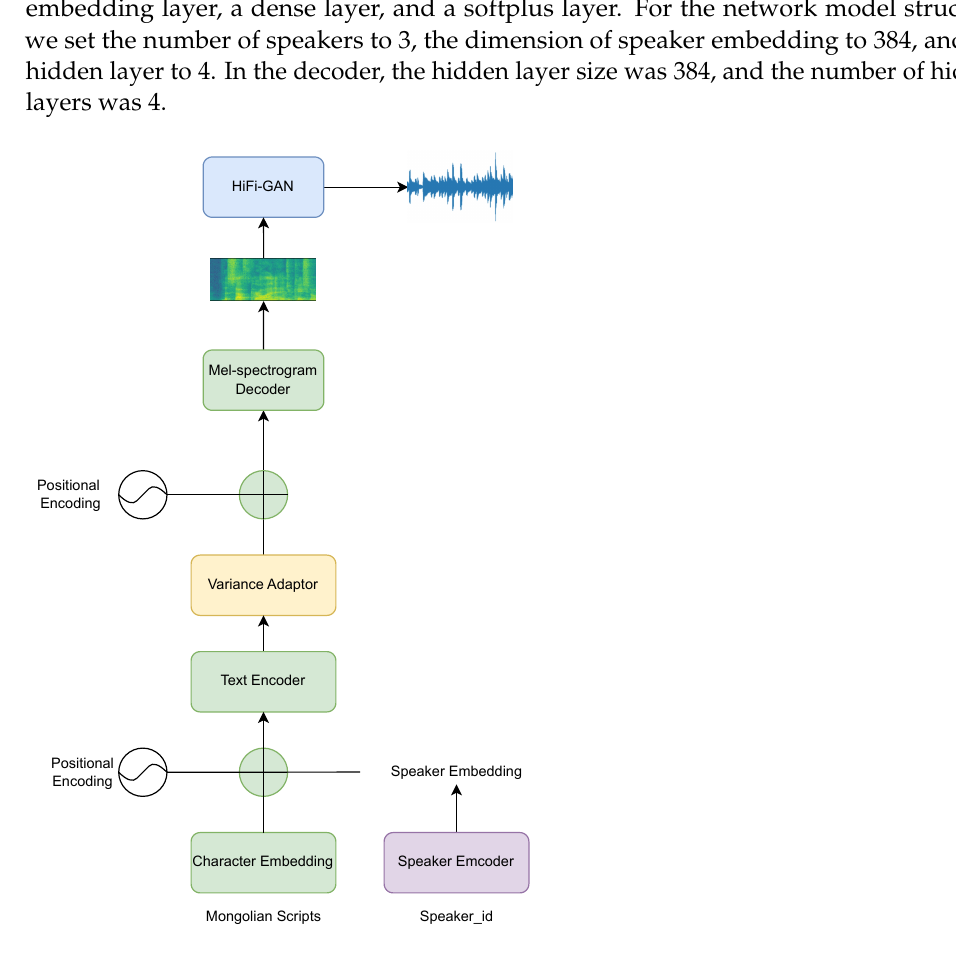
Figure 3. The structure of the FastSpeech2+HiFi-GAN model. We implemented the multi-speaker FastSpeech2 by adding the speaker encoder